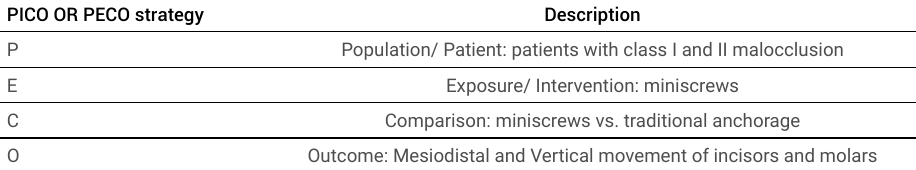
Table 1. PICO OR PECO strategy. PICO OR PECO strategy